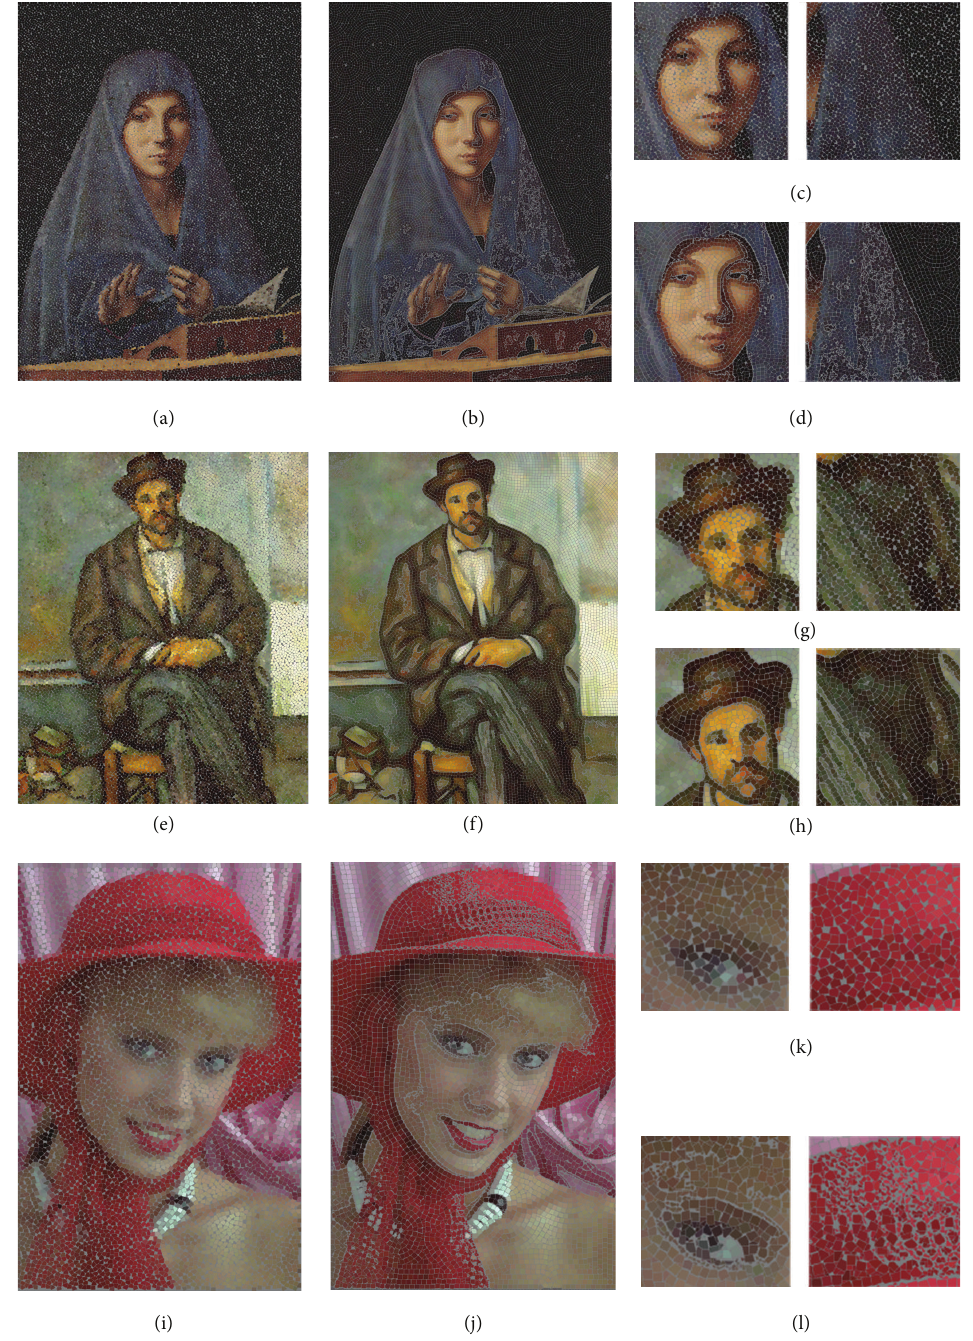
Figure 13: Visual comparisons of artificial mosaic techniques—our approach on the left (a, c, e, g, i, k) and Di Blasi and Gallo [22] on the right (b, d, f, h, j,